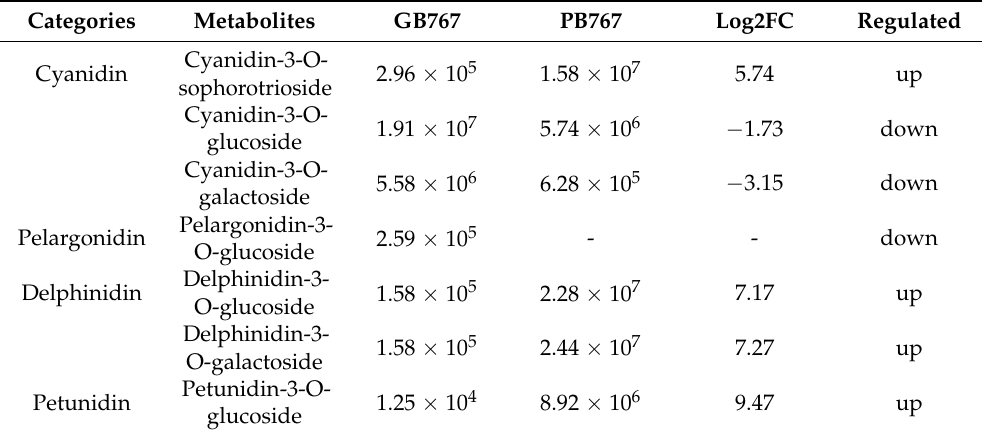
Table 3. The differentially produced anthocyanins in GB767 and